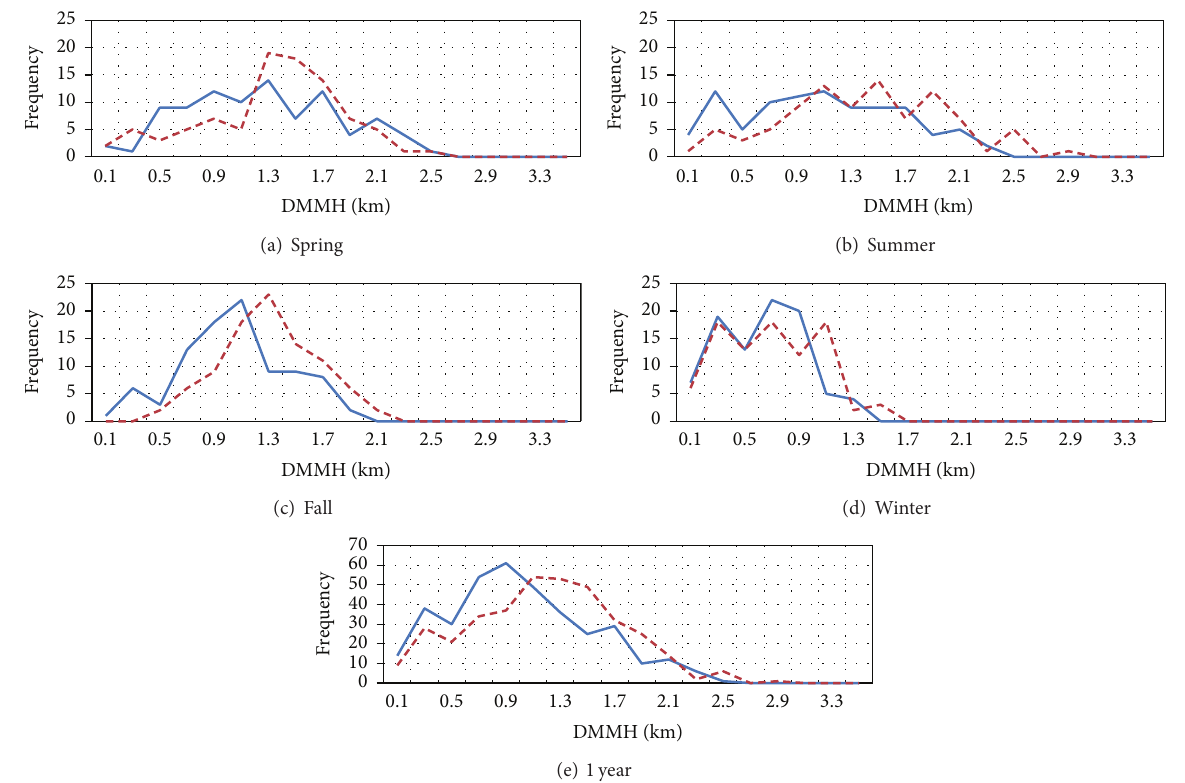
Figure 11: Same as Figure 10 except for model DMMH. The solid (dashed) line denotes Osan (Gwangju).